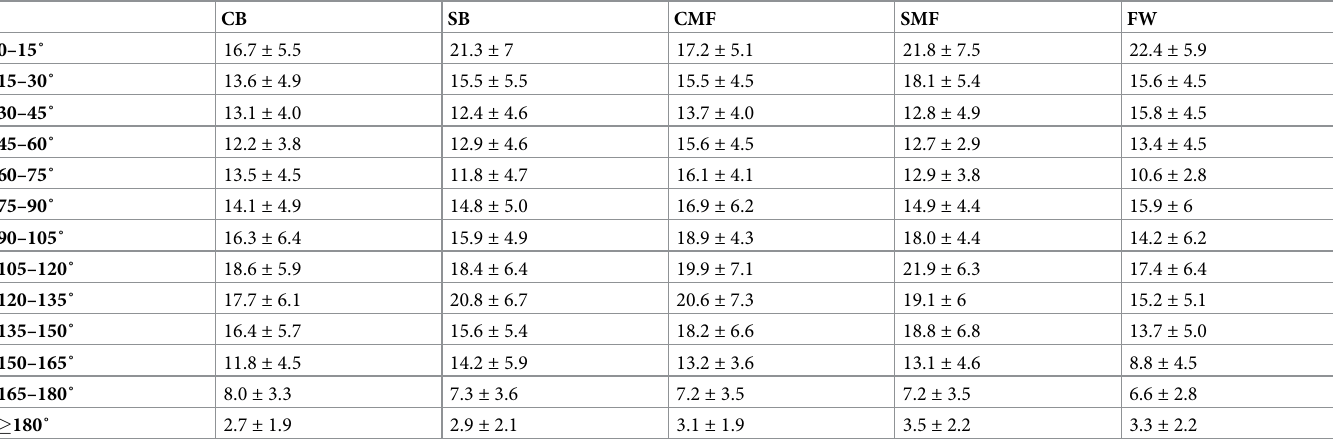
Table 3. Descriptive data on number of CODs per match in each bin range.